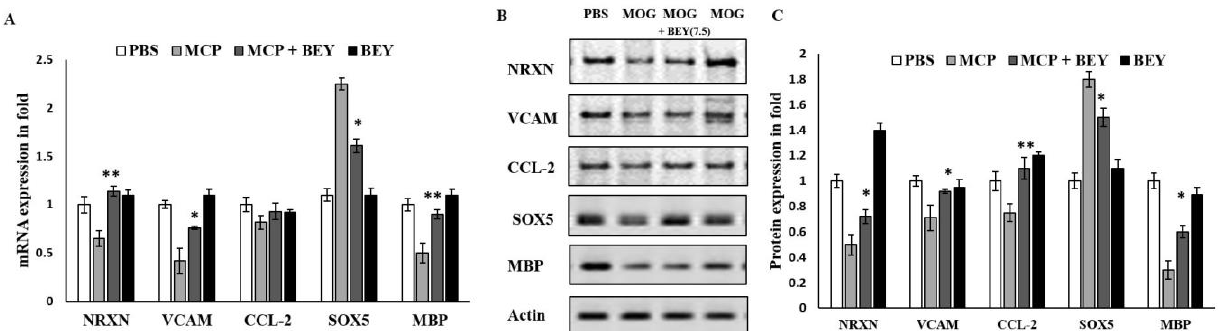
Figure 7. Expression levels of NRXN, VCAM, CCL2, SOX5 and MBP mRNA and protein in MOG- immunized BEY-treated mice. ( A ) mRNAs of NRXN, VCAM, SOX5 and MBP were significantly upregulated in mouse model after BEY treatment. CCL2 was less sensitive in BEY-treated group compared with untreated EAE group. Gapdh was used as internal control to calibrate the expression level. ( B , C ) Protein expression was noted in precisely the same manner as mRNA expression. For protein immunoblot studies, actin was used as an internal control. For each group, values were expressed as mean ± SD. For statistical analysis, one-way ANOVA was used, followed by a post hoc t -test (significant at * p ≤0.05, ** p ≤ 0.01 ).